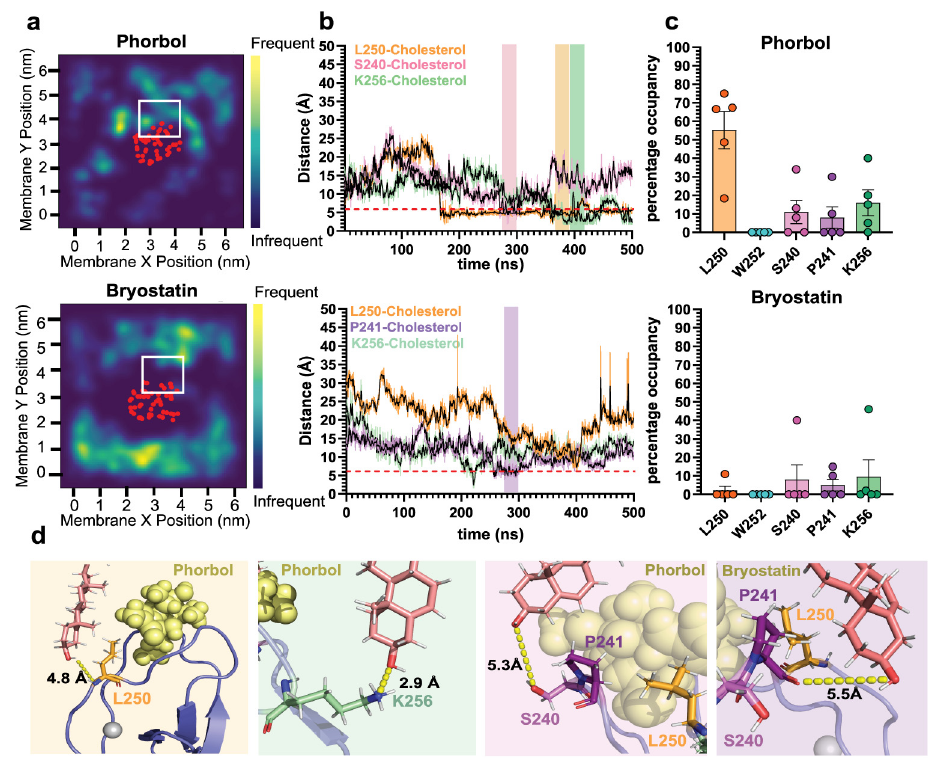
Figure 3. Interactions between cholesterol and δ C1b. Top panels show δ C1b-phorbol simulations. Bottom panels show δ C1b-bryostatin stimulations. ( a ) Heatmaps show the localization frequency of cholesterol in the inner leaflet over 500 ns. The red dots indicate the average position of the backbone C α of δ C1b. Plots are representative of five simulations (full dataset is shown in Figure S4). ( b ) Interaction lifetime of L250 (orange), S240 (pink), K256 (green) and P241 (purple) with cholesterol. The dashed line indicates the 6 Å cutoff used to quantify residue occupancy in ( c ). ( c ) Bar graphs show the mean occupancy of residues with cholesterol across all simulations. Bars indicate the mean, error bars represent the standard error of the mean and each point represents a single independent simulation. ( d ) Representative structural interactions extracted from the simulation time frame indicated by the shaded regions in ( b ). Ligands are shown as yellow spheres, L250 is shown as orange sticks, S240 as pink sticks, P241 as purple sticks and K256 as pale-green sticks. Only one of five bryostatin simulations showed a significant interaction between S240 or K256 (Figure 3b,c), and to a lesser extent L250. Manual inspection of the simula- tions suggested L250 to not be accessible to cholesterol in most simulations due to a shal- lower membrane topology when bound to bryostatin. Topological heatmaps of the aver- age insertion depth and tilt angle of δ C1b-ligand complexes shows δ C1b inserts deeper